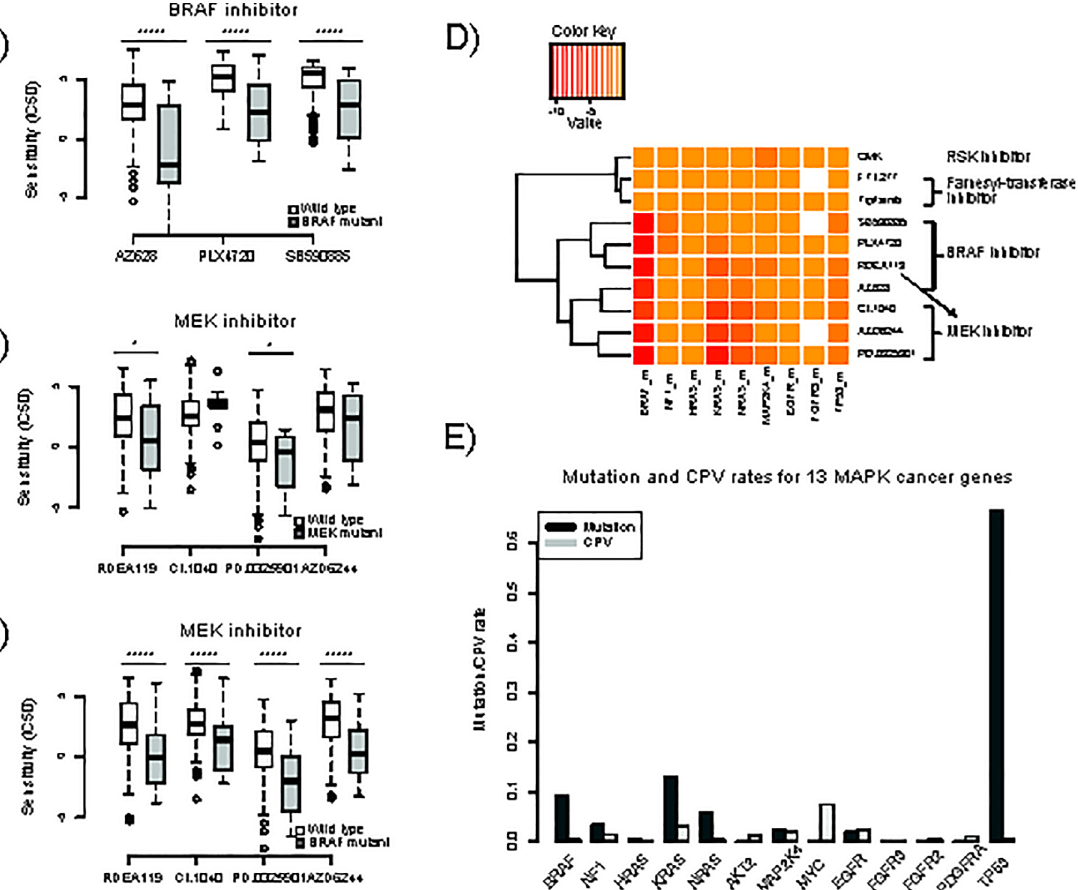
Fig 2. Mutation and drug sensitivity distributions of the CGP dataset. (A) Sensitivities of BRAF wild type and mutant samples to three BRAF inhibitors, i.e., AZ628, PLX4720 and SB590885. P-values by Wilcoxon Rank Sum test are 3.84e-6, 9.98e-10 and 1.33e-11, respectively. (B) Sensitivities of MEK wild type and mutant samples to four MEK inhibitors. (C) Sensitivities of BRAF wild type and mutant samples to four MEK inhibitors. (D) Drug sensitivity differences between wild type and mutant samples for cancer-related genes in MAPK pathway. Color key indicates log p-value between wild type and gene mutation samples by two-sample Wilcoxon Rank Sum test. (E) Mutation and CPV rates of 13 cancer-related genes in MAPK pathway.